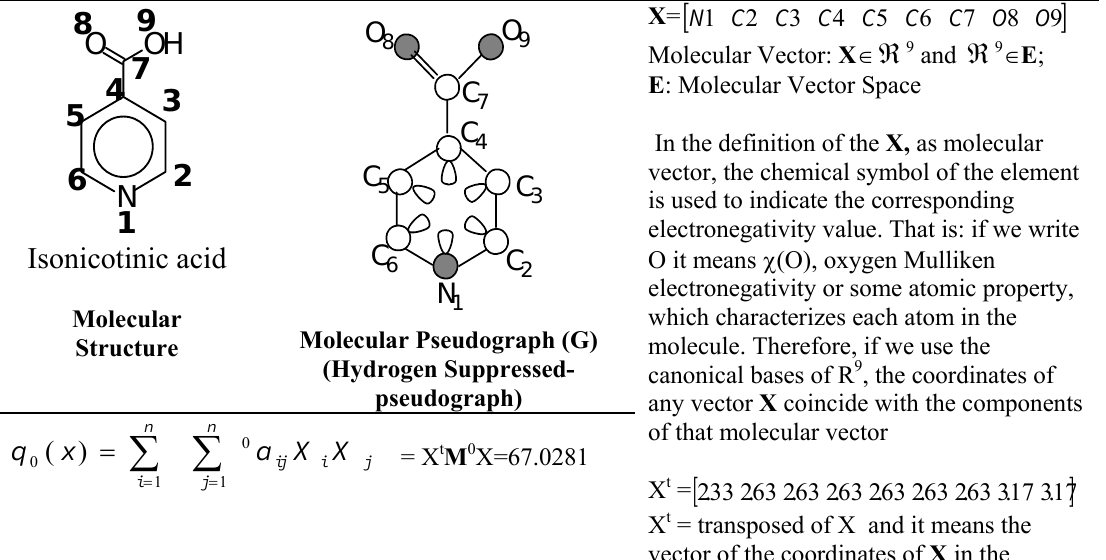
Table 2. Definition and Calculation of Five ( k =0-4) Quadratic Indices of the